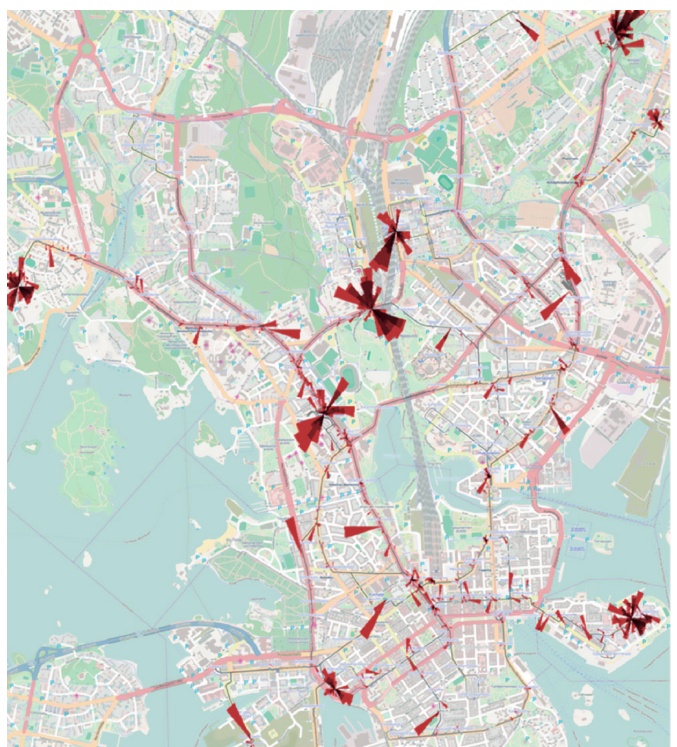
Figure 1. Rose diagrams applied to the spatiotemporal analysis of traffic congestion in Helsinki [15]. The transparency of each circular segment is used to depict the number of occurring traffic jams. The size of each circular segment represents the duration of traffic jams.